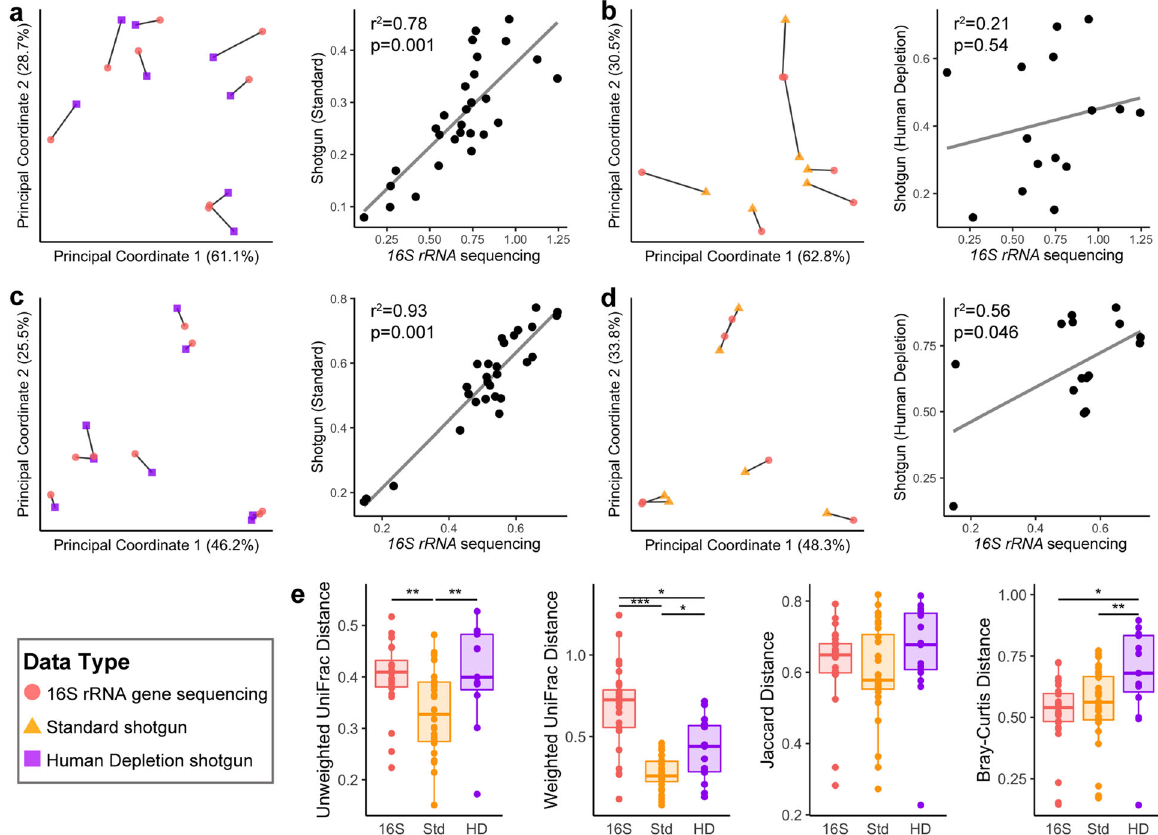
Fig. 7 Procrustes analysis of 16S rRNA gene and shotgun data of phylogenetic beta diversity. Weighted UniFrac ( a ) and Bray – Curtis ( c ) analysis comparing results from the 16S rRNA gene sequencing and the standard extraction shotgun sequencing. Weighted UniFrac ( b ) and Bray – Curtis ( d ) analyses comparing results from the 16S rRNA gene sequencing and human DNA depletion shotgun sequencing. Left panels: PCoA plots from procrustes analysis. Lines connect same samples across sequencing type. Right panels: Correlation plot from Mantel test comparing the two distance matrices. e Comparison of distances of all the shared samples between sequencing types. Center line on plots indicates median, box is IQR. * p < 0.05, ** p < 0.01, *** p <